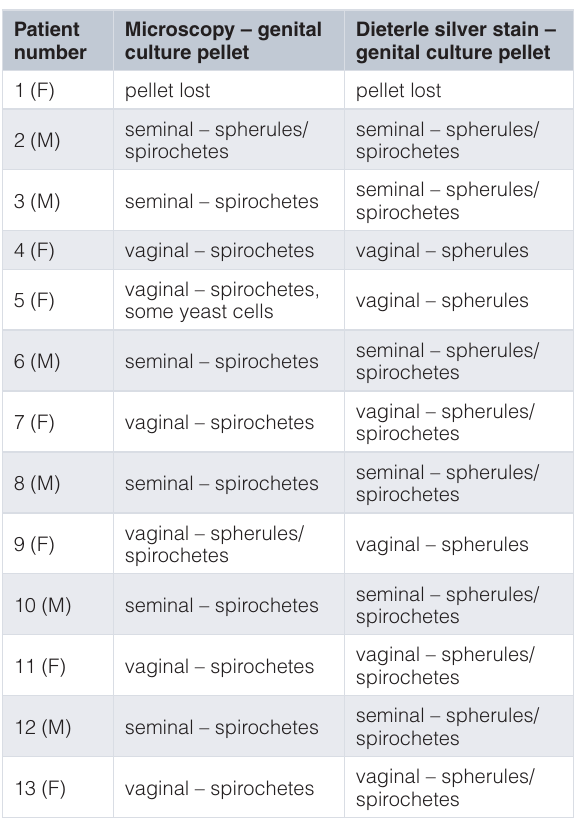
Table 3. Microscopy results and Dieterle silver staining of genital culture concentrates. See Dataset, data file